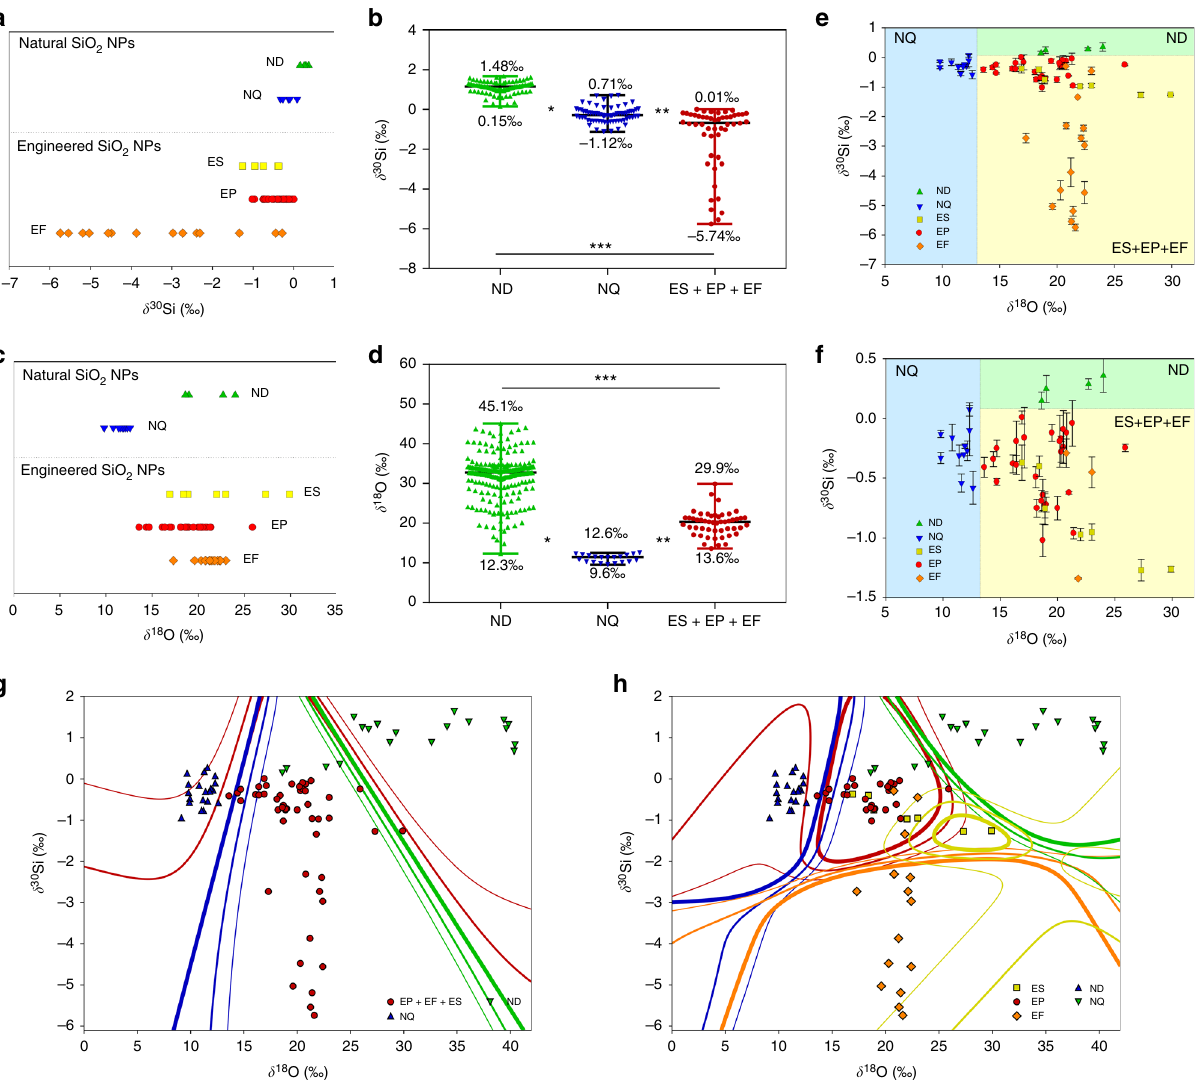
Fig. 2 Si and O isotopic fi ngerprints of SiO 2 NPs of different origins. a , b Si isotopic composition of SiO 2 NPs grouped according to sources. c , d O isotopic composition of SiO 2 NPs grouped according to sources. The dots in a and c represent the samples tested in this study, and those in b and d include available data in the literature 20,21,32 – 41 . In b and d , * P < 10 -4 , ** P < 10 -4 , and *** P < 10 -4 . Unpaired Student ’ s two-tailed t-test was used. e , f , Si-O 2D isotopic fi ngerprints of SiO 2 NPs with source differentiation by two straight lines ( δ 18 O = 13 ‰ and δ 30 Si = 0.1 ‰ ). The f is a partial enlarged view of e . The different colored zones represent different sources (NQ or ND or ES + EF + EP). The error bars represent 2s.d. ( n = 2-5). g , h Si-O 2D isotopic fi ngerprints of SiO 2 NPs with linear discriminant analysis (LDA) into three ( g ) or fi ve classes ( h ). The zones de fi ned by colored contour lines representing virtual distribution ranges of different sources given by the LDA-based classi fi ers. The color and thickness of the contour lines correspond to the respective sources and the probabilities of a sample being predicted to be the related class (0.5, 0.4, 0.3 for the thick, normal, and the thin one, respectively). Note that the ND and NQ samples in g , h include both the real samples used in this study and pseudo-samples constructed using the δ 30 Si and δ 18 O data reported in the literature (see Supplementary Methods